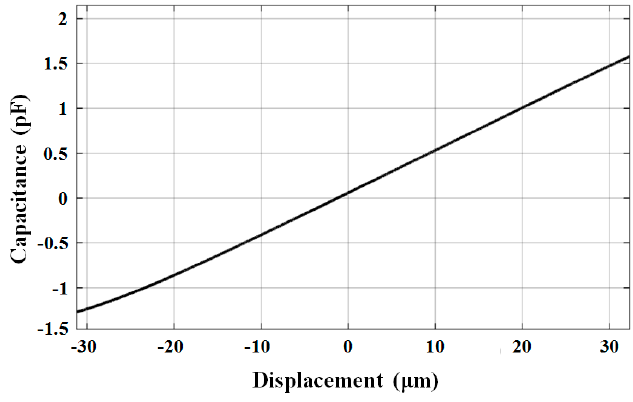
Figure 10. Sensitivity calibration of the capacitive transducer.